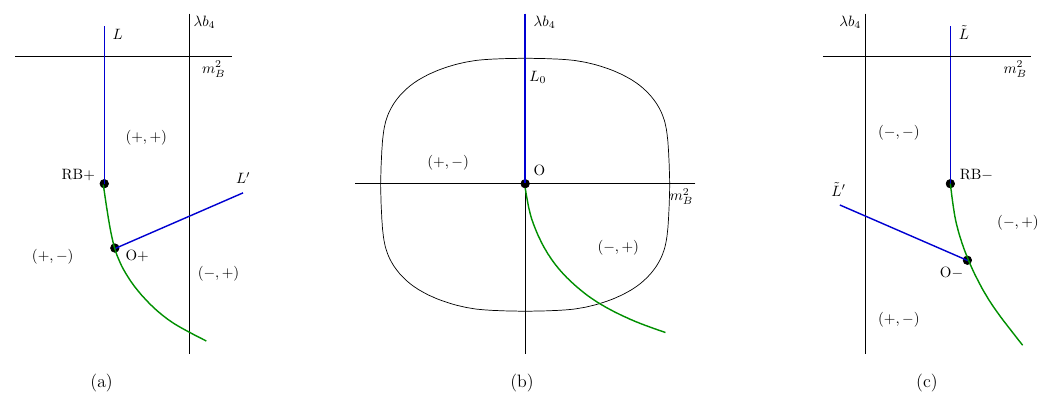
Figure 12. The phase structure for the (a) m F = j (cid:22) j sgn( (cid:21) ), (b) m F = 0, (c) m F = (cid:0)j (cid:22) j sgn( (cid:21) ) sections for j (cid:21) j < 1 . The blue lines are second order phase transitions while the green lines are (cid:12)rst 2 order transitions. The lines L , ~ L correspond to the critical boson theory CB (cid:6) and L 0 , ~ L 0 correspond to the regular fermion theory RF (cid:6) . The phase diagram for m F = 0 is the equatorial ellipse shown in (cid:12)gure (b) and given by (4.9). The intersection of the line L 0 with this section is a second order point described the CB-RF theory. The point O in (cid:12)gure (b) is the N = 2 superconformal